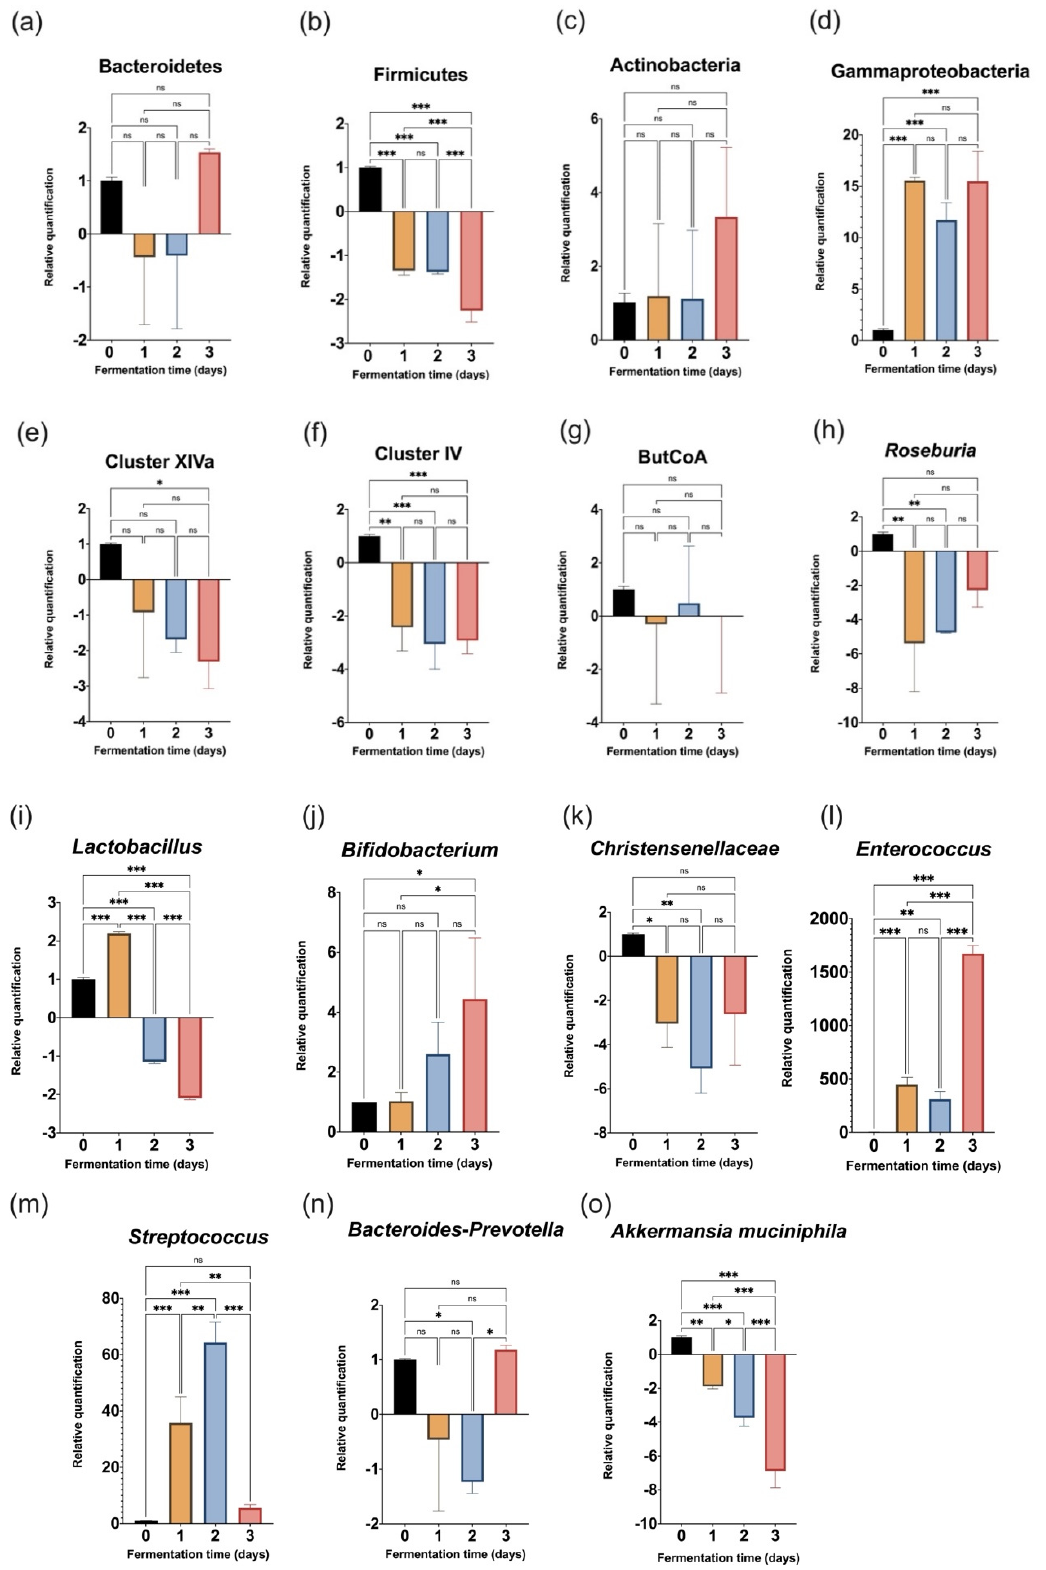
Figure 2. Relative quantification of fifteen target taxa assessed by qPCR analysis. Data are presented as mean ± SD fold-changes calculated using 2 −ΔΔ Cq method [42]. Comparisons were performed by means of one-way ANOVA, followed by Bonferroni post-test, and statistical significance is indicated as p < 0.05 (*), p < 0.01 (**), p < 0.001 (***), and p > 0.05 (ns).